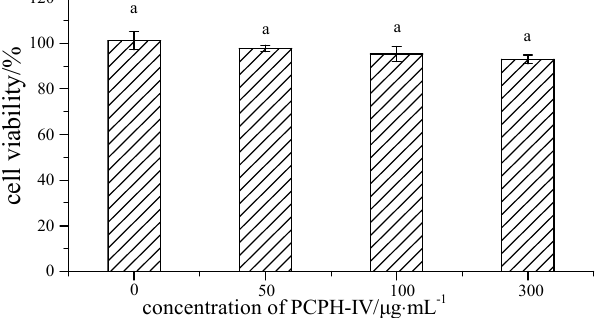
Figure 2. Effects of PCPH-IV on HepG2 cell viability. Bars labeled with the same letter are not significantly different ( p > 0.05).